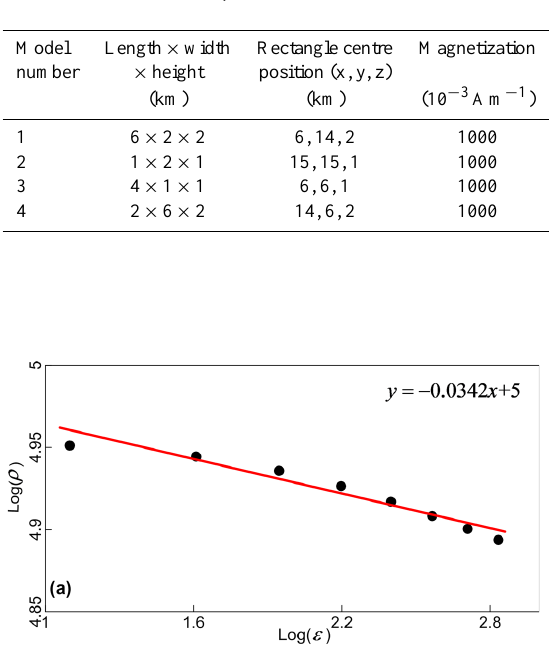
Table 2. Theoretical model parameters.